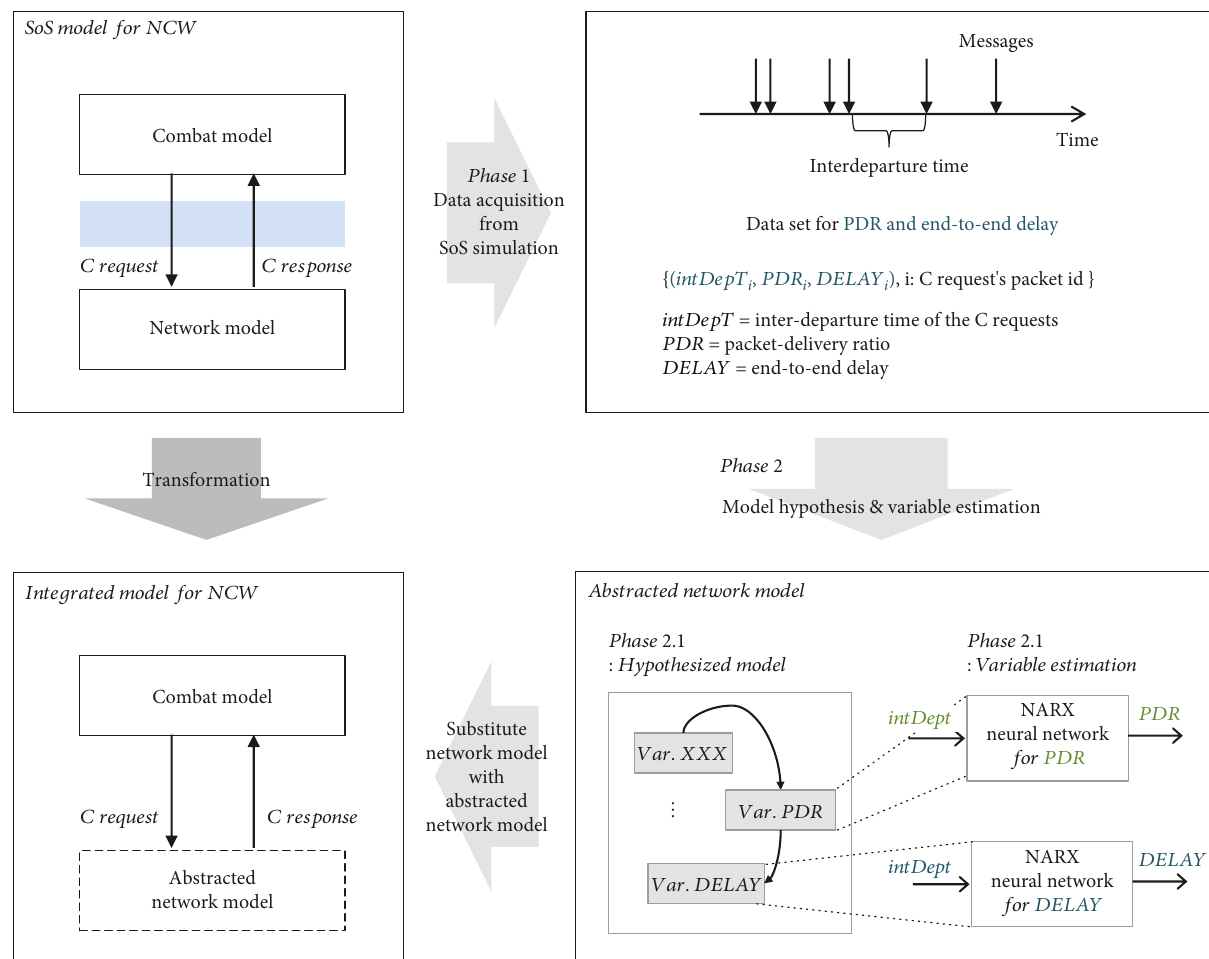
Figure 6: Transformation description via the model hypothesis and variable estimation